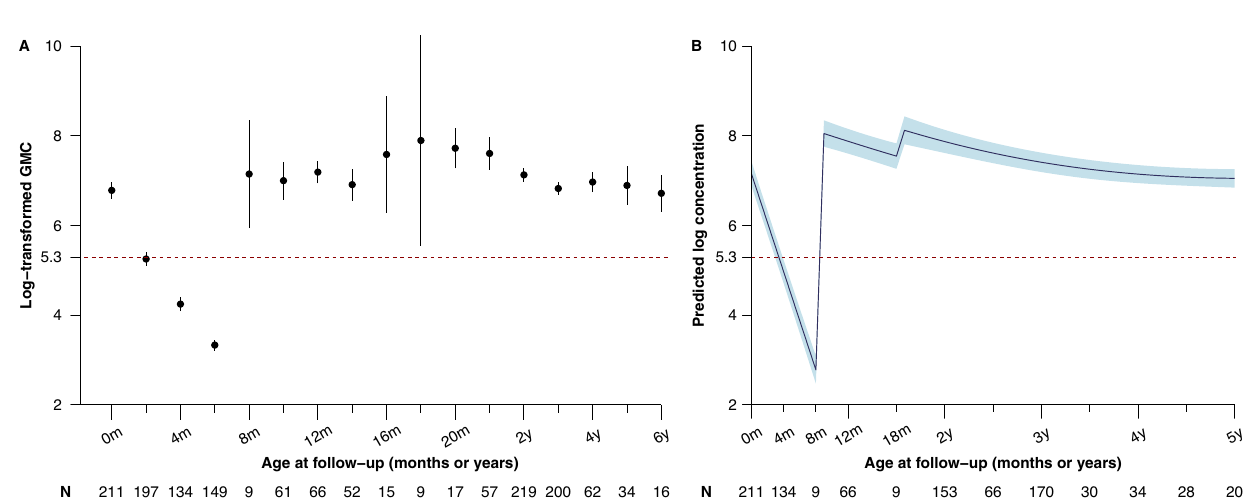
Fig. 2 | Fitted pro fi les for measles antibody concentrations among children with the fi rst dose of MCV at 8 months. A Observed and B predicted log- transformed geometric mean concentrations. The points in A refer to the log- transformed geometric mean concentrations.The thickcurve in B is the predicted